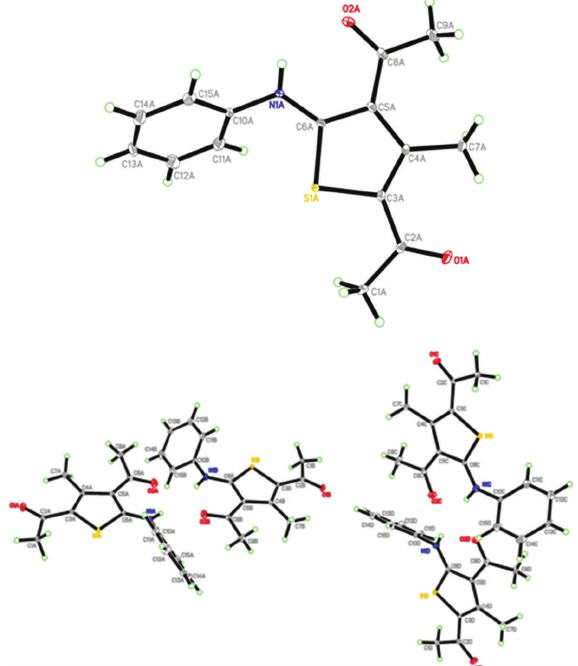
Figure 1: ORTEP of the synthesized compound 2 .